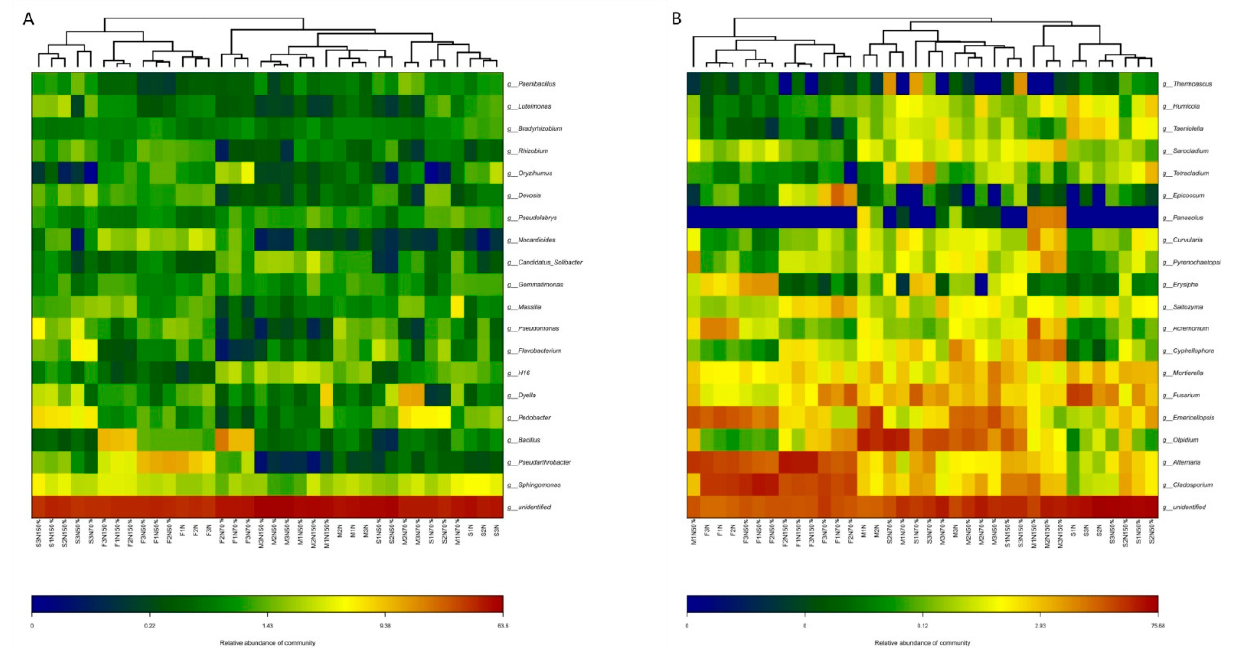
Figure 5. Histogram and heatmap from twenty samples at the level of genus. ( A ) Bacteria; ( B ) Fungi.